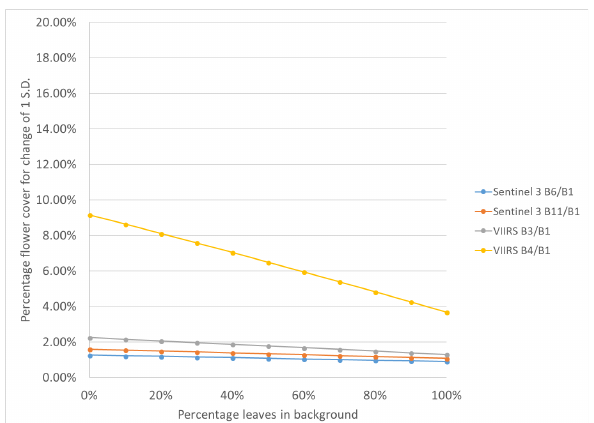
Figure 11. Percentage cover of flowers require to change the reflectance by 1 standard deviation for different ratios of ground and leaves for Sentinel 3 and VIIRS derived